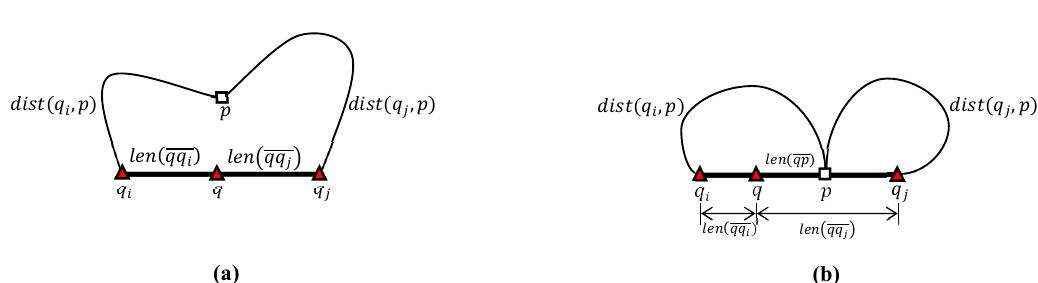
Figure 6. Computation of the distance between query point q in query segment q i q j and data point p : ( a ) p / ∈ q i q j . ( b ) p ∈ q i q j